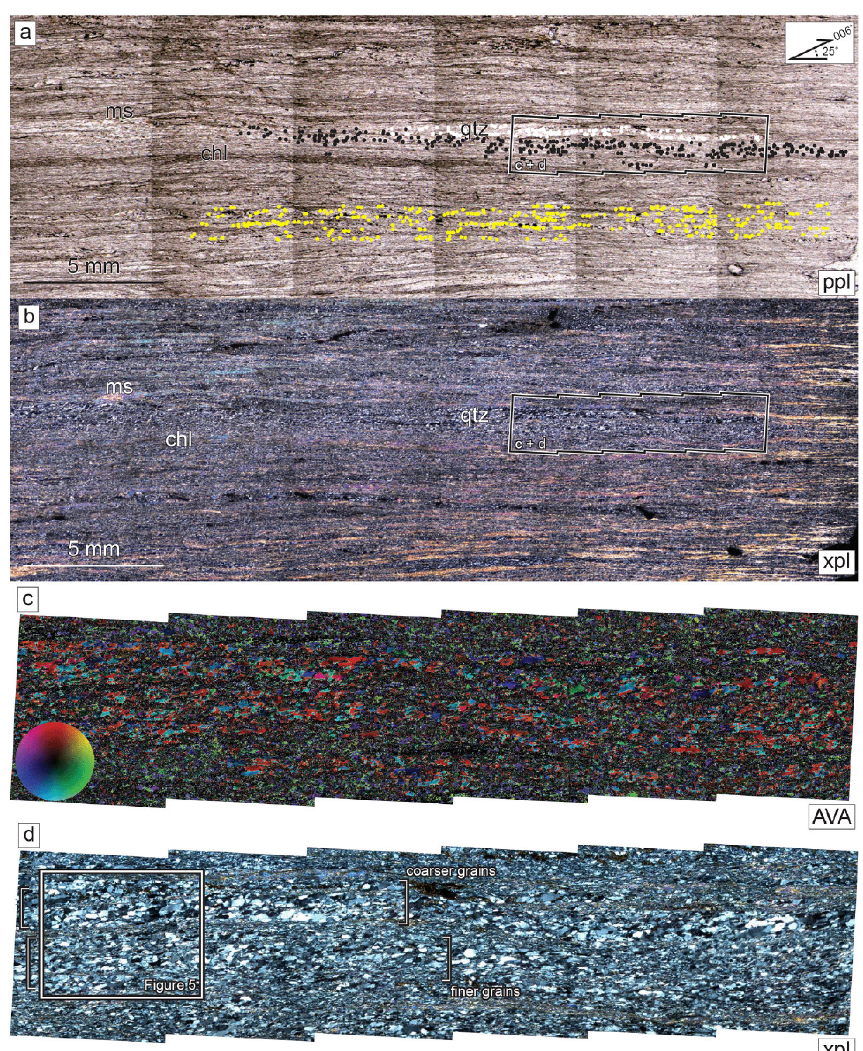
Figure 2. Thin section scale photomicrographs of specimen S32 presented in plane-polarized light (a) , cross-polarized light (b) , and as an AVA diagram (c) . The location of quartz grains analysed is indicated by different coloured and shaded circles in (c) . White circles denote a coarser grain within the quartz-rich lens; black circles indicate a finer grain within a quartz-rich lens; yellow circles mark a matrix quartz grain measured. A more detailed cross-polarized photomicrograph of the quartz-rich lens is shown in (d) ; coarser and finer populations are